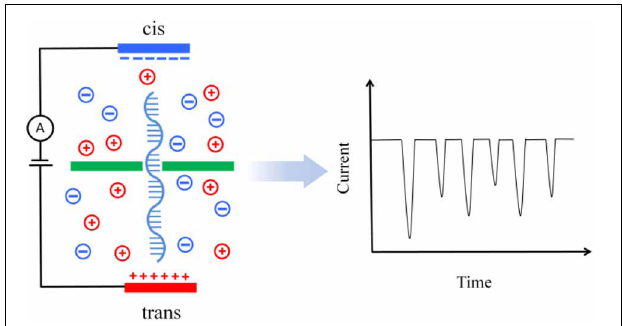
FIGURE 1 | Illustration of translocation of a DNA molecule through a nanopore device. The pore divides the solution into two parts. A bias voltage is applied across the pore to generate an electric field perpendicular to the wall and to drive the DNA through the pore. The DNA translocation is monitored by the blockade current (schematically illustrated on the right) associated with the nucleotides through the